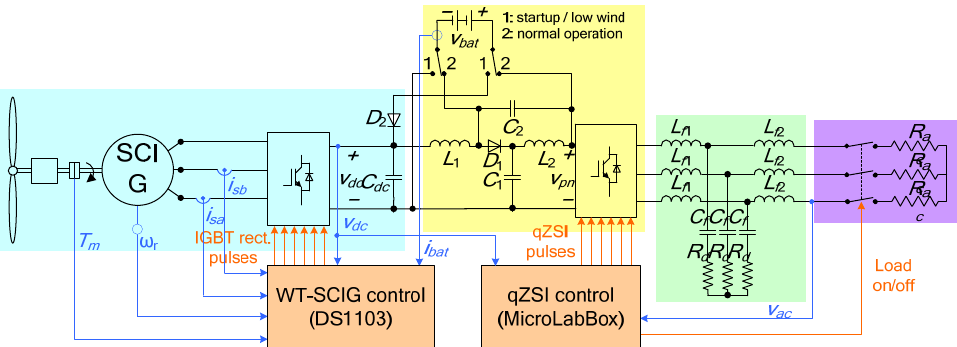
Figure 1. Configuration of the proposed quasi-Z source inverter (qZSI)-based wind energy conversion system (WECS) including a wind turbine (WT)-driven squirrel-cage induction generator (SCIG) (cyan), qZSI with batteries (yellow), LCL filter (green), alternating current (AC) load (purple), and control algorithms (orange).